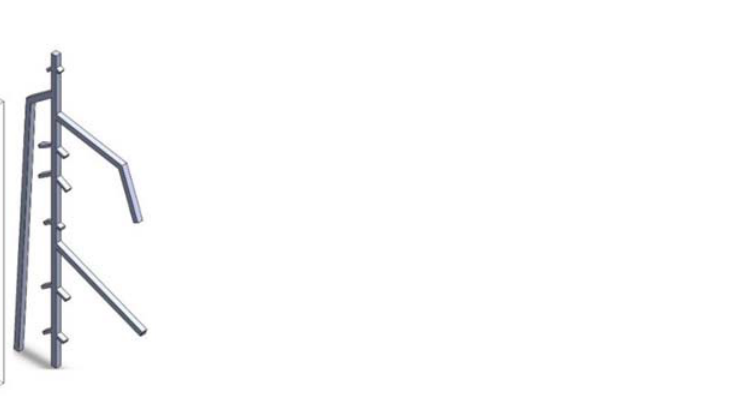
Figure 1. Transparent isometric view of RSA model ( left ) and isometric view of sugar beet root model ( right